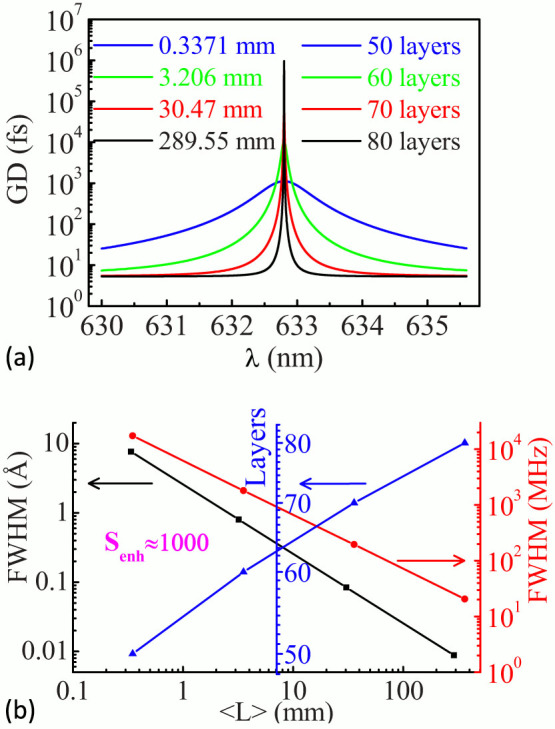
(a) Computed group delay as a function of wavelength for ring lasers with different cavity optical length <L> of 289.55 mm (black curve), 30.47 mm (red curve), 3.206 mm (blue curve) and 0.3371 mm (green curve), respectively. The corresponding multilayer coatings are 80 (G/(HL)25H2L(HL)14/A), 70 (G/(HL)232H(LH)11L/A), 60 (G/(HL)20H2L(HL)9/A) and 50 layers (G/(HL)182H(LH)6L/A), respectively. (b) The FWHM bandwidth of GD(λ) (in black), the FWHM bandwidth of Senh (Δf) (in red) and the layers of multilayer coatings (in blue) as a function of laser cavity optical length <L>, respectively.